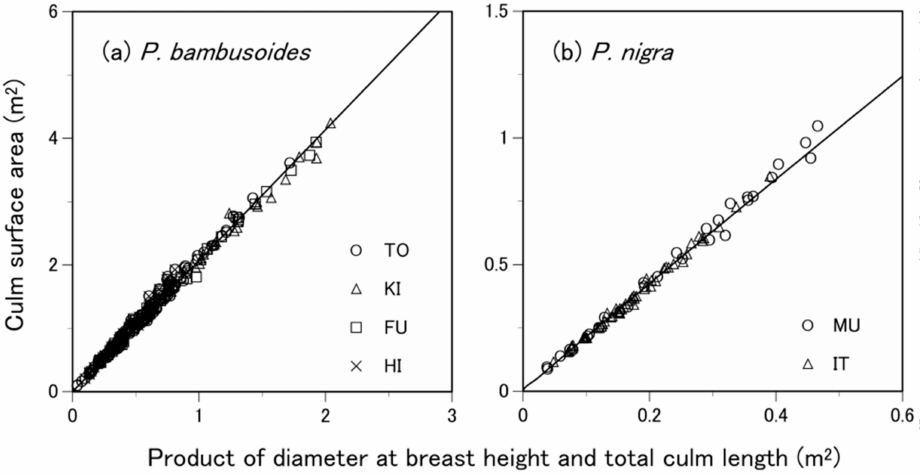
Figure 4. Relationships between culm surface area and product of diameter at breast height and total culm length in ( a ) Phyllostachys bambusoides and ( b ) P. nigra . The solid lines represent the linear equations detailed in Table